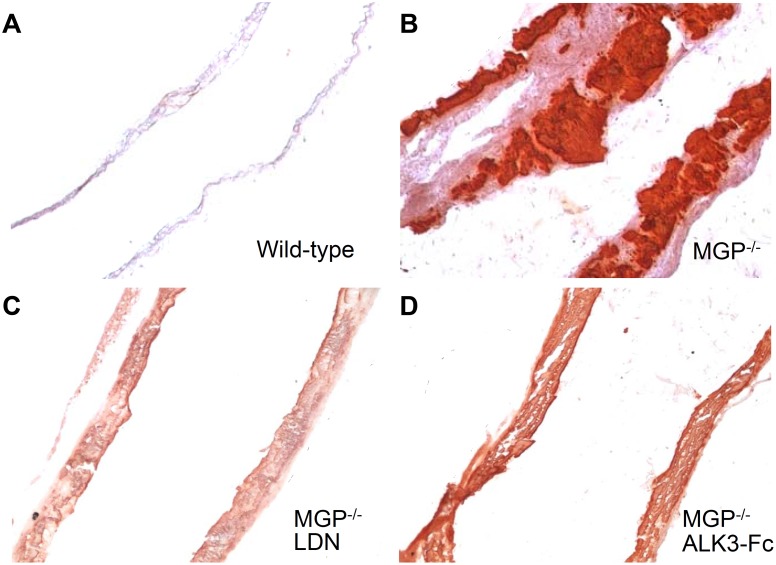
Vascular calcification associated with MGP deficiency is dependent on bone morphogenetic protein signaling.Aortas were harvested from mice at 28 days of age, sectioned, and stained for tissue calcium with Alizarin Red. Sections from wild-type (A) and MGP-/- (B-D) mice were photographed at 100x magnification. Starting at day 1 of age, MGP-/- mice were treated with i.p. injections of vehicle (B), LDN-193189 (LDN, 2.5 mg/kg daily, C), or ALK3-Fc (2 mg/kg every other day, D). Inhibition of BMP signaling reduced aortic calcification in MGP-/- mice.